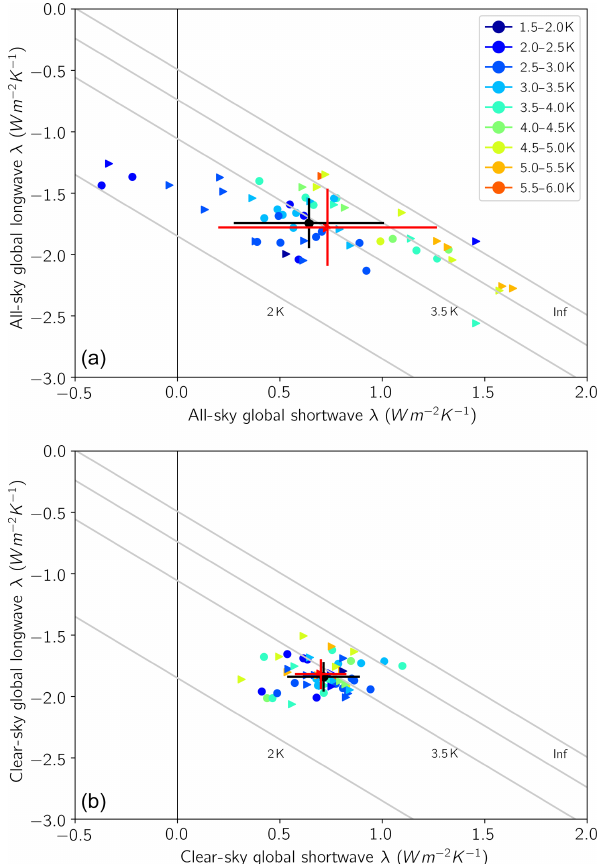
Figure 4. All-sky λ LW versus λ SW for the CMIP5 and CMIP6 en- semble (a) and clear-sky λ CS,LW versus λ CS,SW for CMIP5 and CMIP6 (b) . CMIP5 is shown as circles, and CMIP6 is shown as right-facing triangles. Mean CMIP5 feedbacks and SDs are shown as black circle and lines, and mean CMIP6 and SDs are shown as dark gray triangle and lines in each plot. Lines of constant ECS based on forcing of 3.7Wm − 2 are given in light gray. Plot symbols colored by ECS values are as shown in the legend.